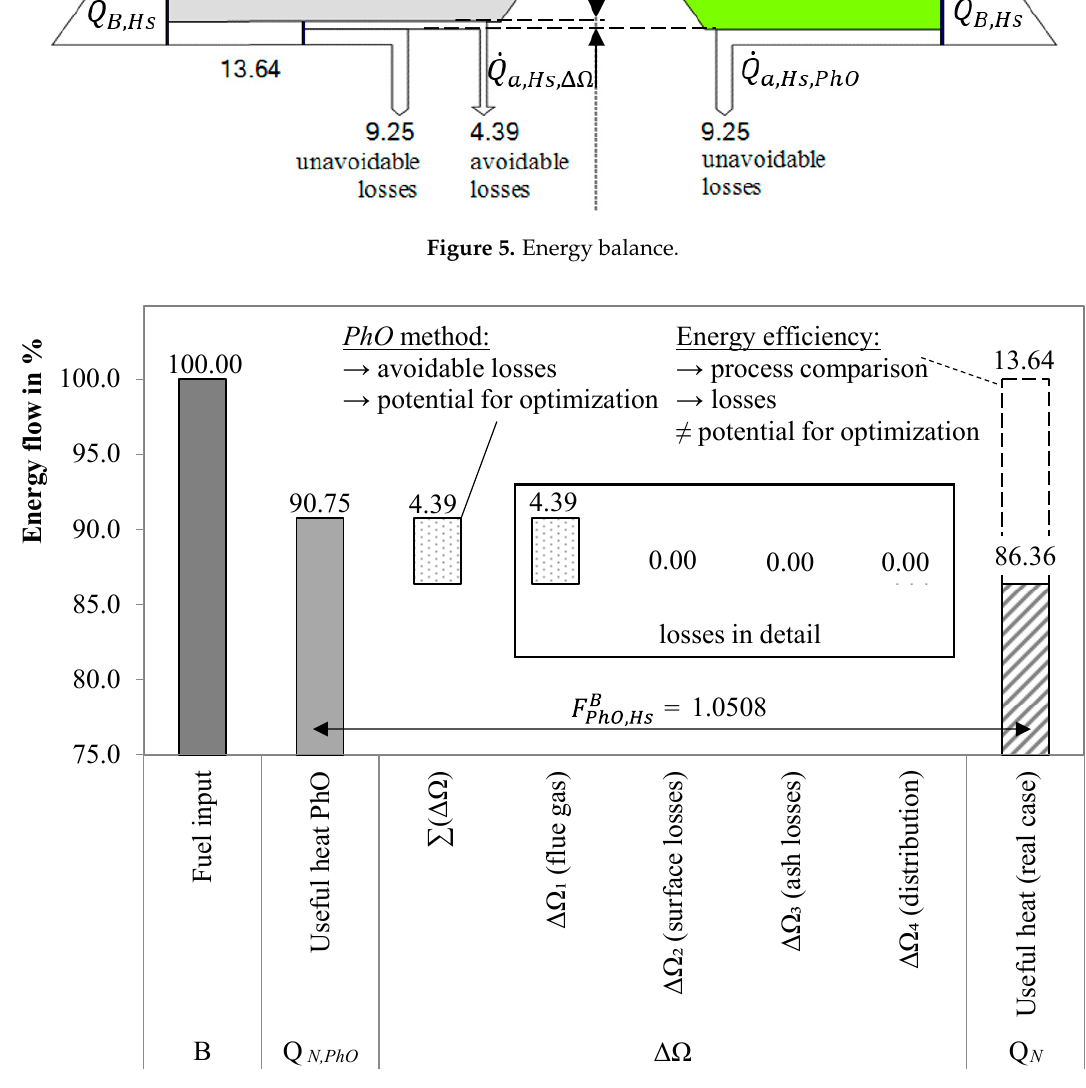
Figure 6. Cascade of losses for boiler.